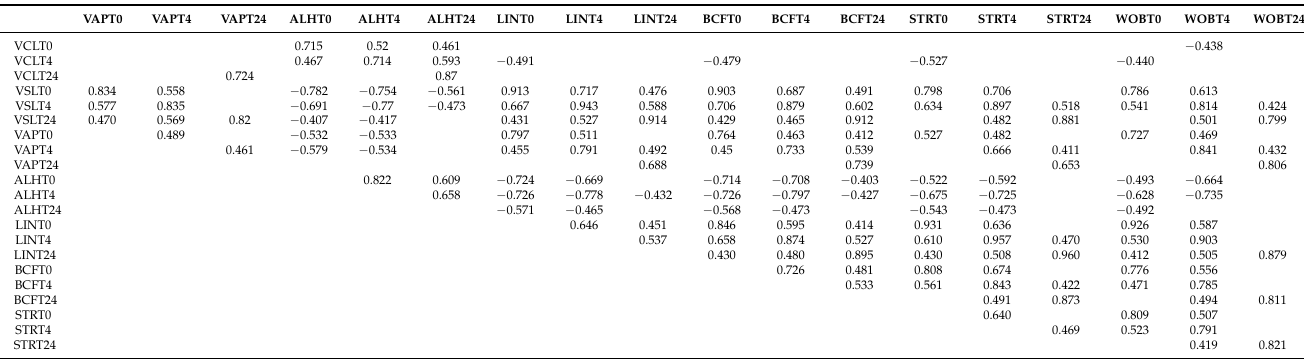
Table 2. Pearson coefficients ( r ) for correlations between kinetic parameters in bull semen, determined with CASA after three durations of storage in the presence of three semen extenders at two holding